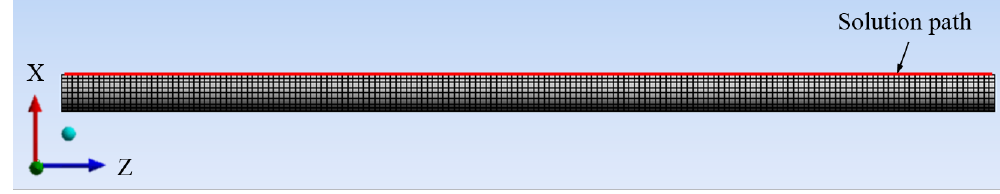
Figure 2. Finite element geometry model.